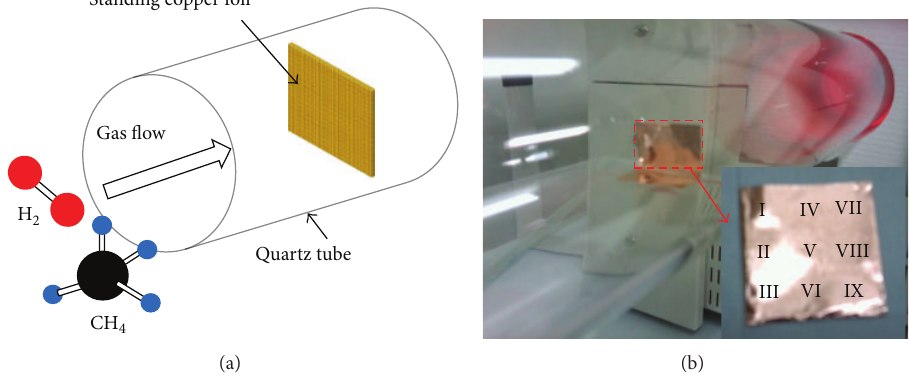
Figure 1: (a) Schematic representation of the LPCVD system showing the (b) copper foil standing on the quartz plate. The inserted image displays marks on the copper foil for SEM measurement.